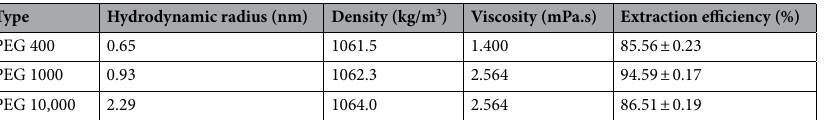
Table 1. Effect of PEG on the extraction of Co(II) (T = 25 °C; Time = 15 min; Co(II) = 500 ppm, PEG = 50% w/w, pH = 2).